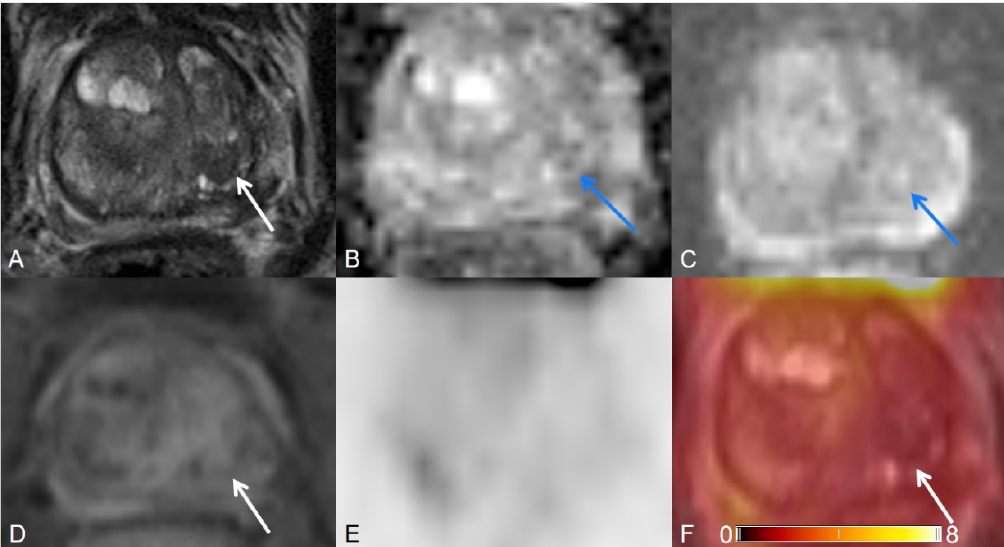
Figure 3. Transition zone with an atypical nodule. ( A ) Axial T2WI shows a T2 hypointense homogeneous circumscribed nodule. ( B ) ADC map image presents a focal lesion with a mildly hypointense signal below the background corresponding to the lesion seen in ( A ). ( C ) DWI (b = 1000 s/mm 2 ) shows a focal lesion with a mildly hyperintense signal above the background corresponding to the lesion seen in ( A,B ). ( D ) Early dynamic contrast-enhanced image presents no early enhancement within the nodule. T2WI = 2, DWI = 3, DCE = negative, PI-RADS assessment category = 2. ( E ) PET image shows no [ 68 Ga]Ga-PSMA-11 avid uptake. ( F ) [ 68 Ga]Ga-PSMA-11 PET/MRI fusion. Third, revision in criteria for DWI scores of 2 and 3. In PI-RADS V2.0, the description of DWI